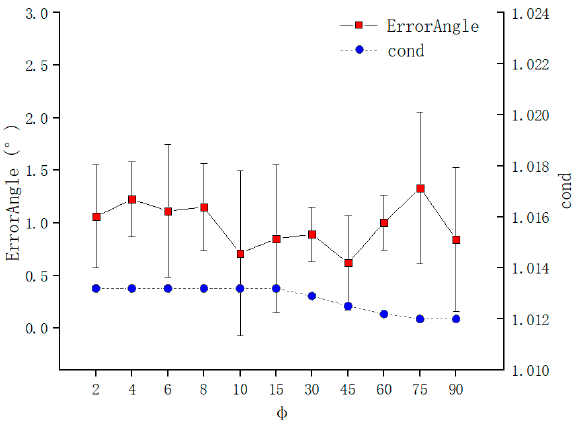
Figure 13. Error of TCPF with φ